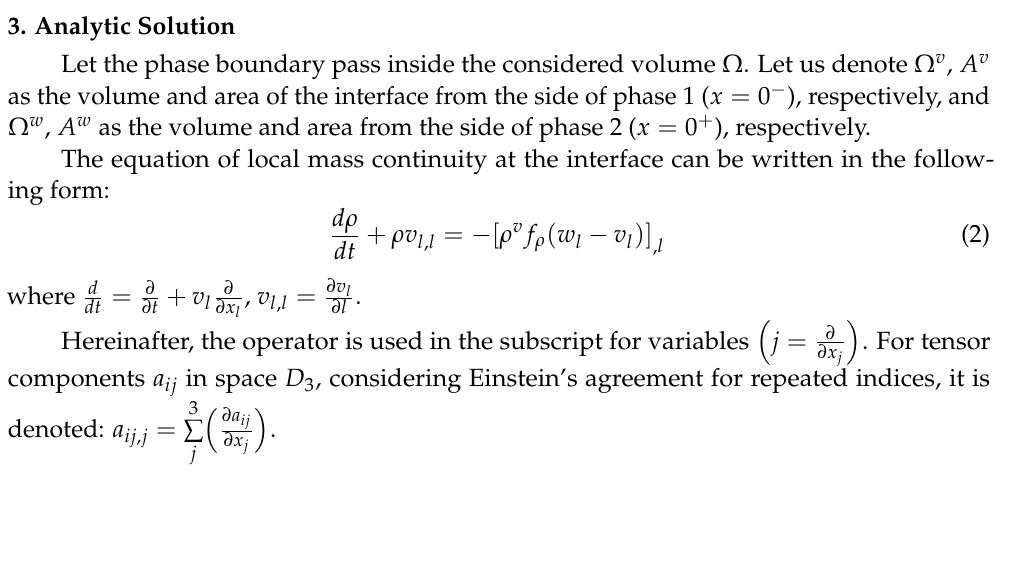
Figure 4. Thermodynamic connection of two phases: 1—phase 1, 2—phase 2, 3—interface area. Using the introduced coefficient f ρ , we establish a connection between the considered velocity fields: Σ where v is the speed of movement of the consolidated two-phase i